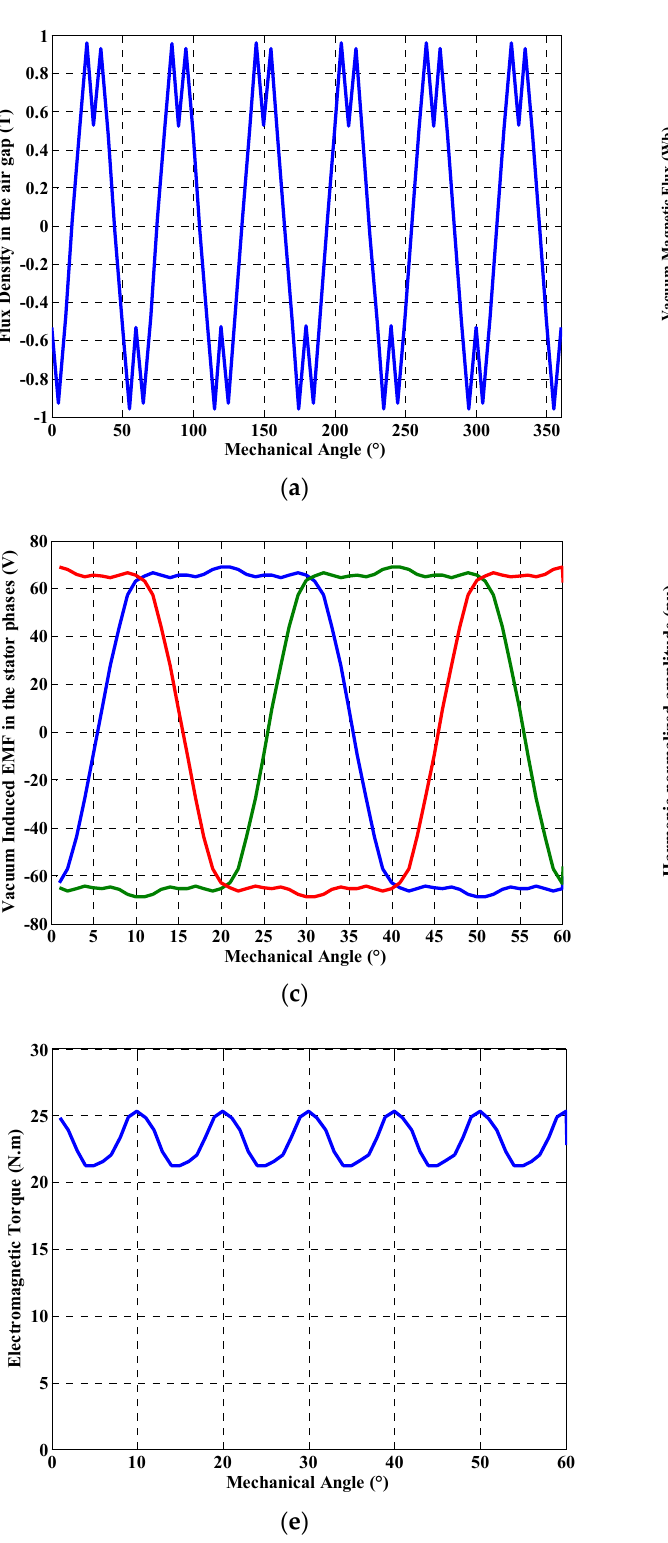
Figure 8. Finite element analysis results of electromagnetic graders within the permanent magnet synchronous generator: ( a ) flux density in air gap vs. mechanical angle, ( b ) vacuum magnetic flux vs. mechanical angle, ( c ) vacuum induced EMF in stator windings vs. mechanical angle, ( d ) fast Fourier transform (FFT) of vacuum induced EMF in stator phases and ( e ) electromagnetic torque vs. mechanical angle.